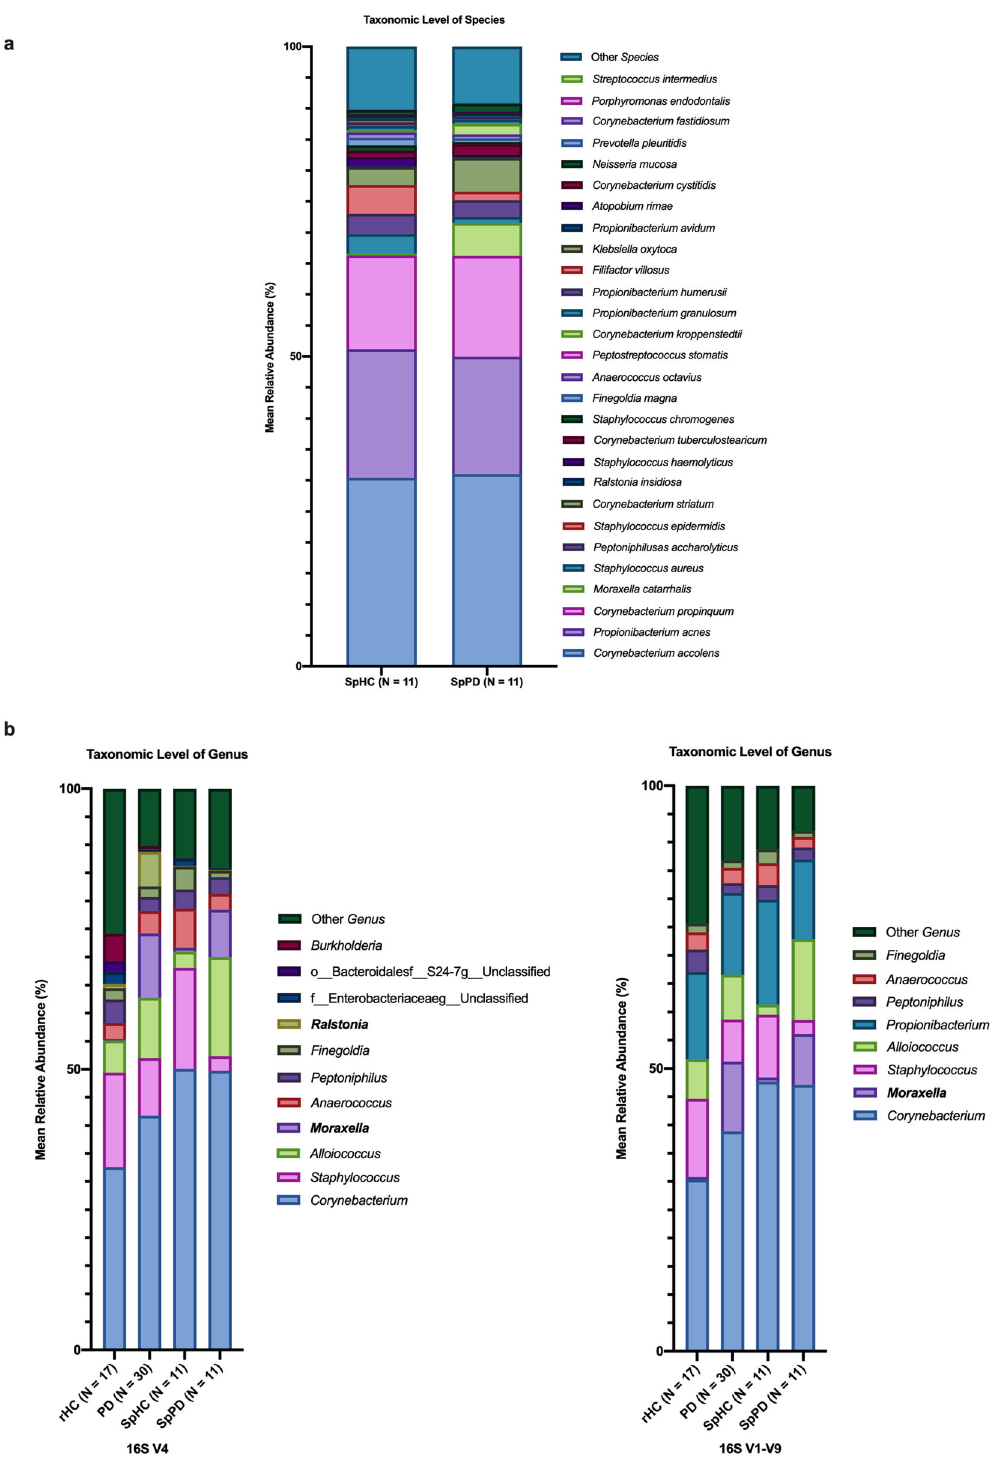
Fig. 3 Mean relative abundances of the deep nasal microbiota between spousal PD and spousal healthy control subjects, and comparison of two different 16S rRNA gene amplicon sequencing protocols. a Bar plot of the deep nasal microbial communities of SpHC and SpPD subjects. The mean relative abundance of species with greater than 1% average relative abundance are shown. b Bar plots of the deep nasal microbial communities of rHC, PD, SpHC, and SpPD subjects using the single amplicon (V4) sequencing protocol and the multi- amplicon (Swift) sequencing protocol. Bar plots are shown for the mean deep nasal microbial community of each group at the taxonomic level of genus. Only those taxa with at least 1% average relative abundance are